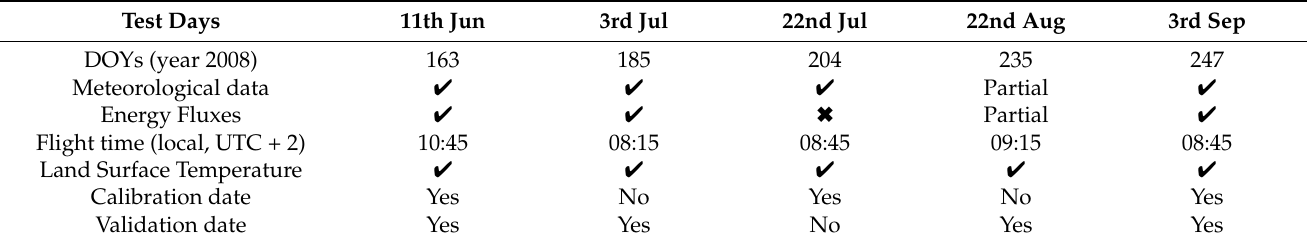
Table 1. Overview of available data. “ (cid:52) ” sign for available data, “ (cid:54) ” for absence of data.